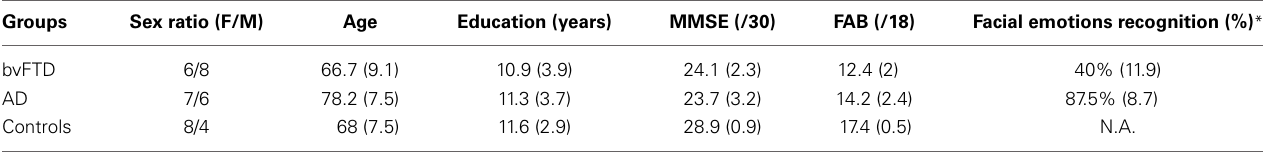
Table 1 | Clinical and demographic data for the participants.